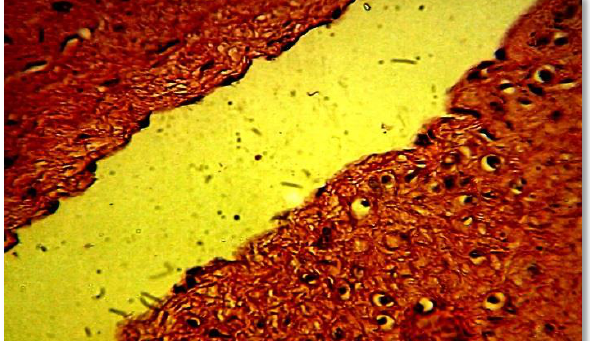
Figure,13: Section in the aorta of rabbit after 42 day of treatment with methionine over load and pometon (group T2) . Note: clear lesions (H &E stain 40X).